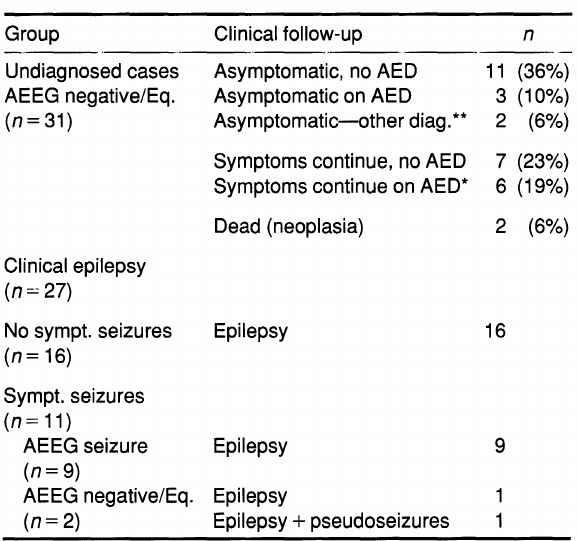
TABLE II. Results of neurological follow-up of undiagnosed patients and epilepsy controls